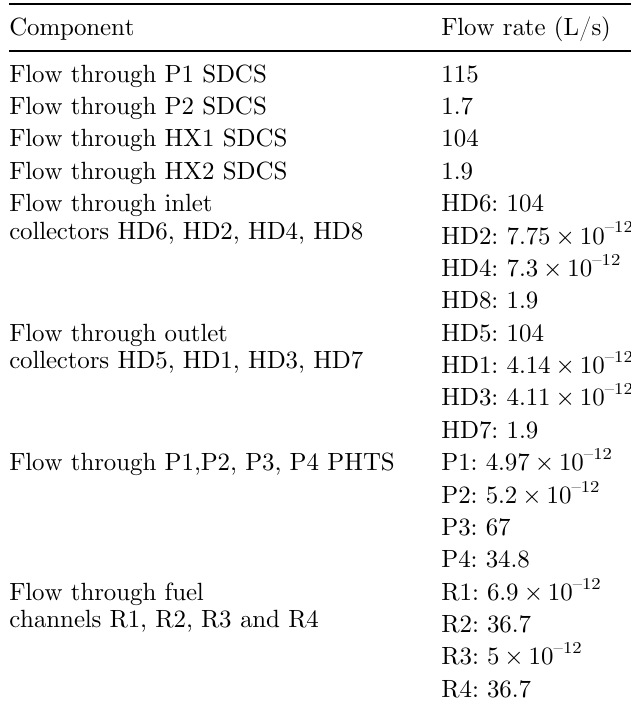
Table 3. Hydraulic analysis. Model II.